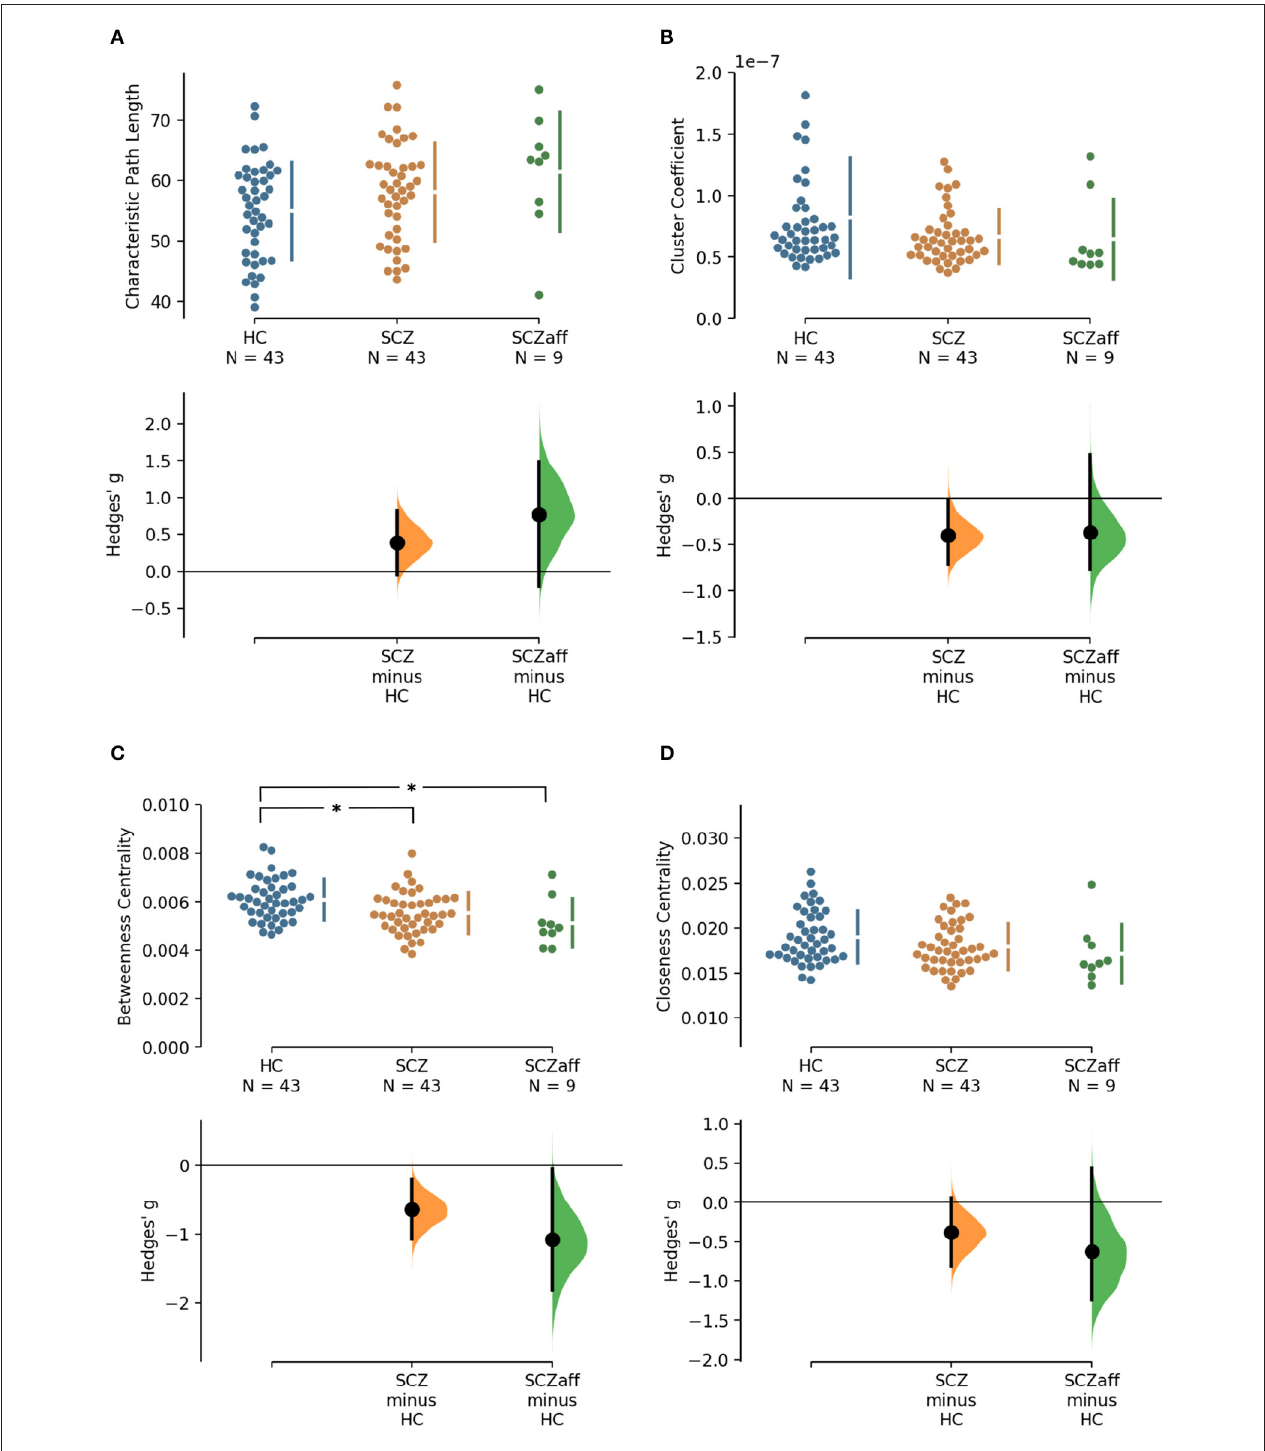
FIGURE 1 | Hedge’s g for the comparisons of various graph measures for the SCZ and SCZaff groups against the HC group are shown in the above Cumming estimation plot. The raw data is plotted on the upper axes. On the lower axes, mean differences are plotted as bootstrap sampling distributions. Each mean difference is depicted as a dot. Each 95% confidence interval is indicated by the ends of the vertical error bars [see (30)]. Panels show (A) characteristic path length (measure of integration), (B) cluster coefficient (measure of segregation), (C) betweenness centrality (measure of centrality), and (D) closeness centrality (measure of centrality). *Denotes statistically significant differences at a significance level of 0.05 Bonferroni